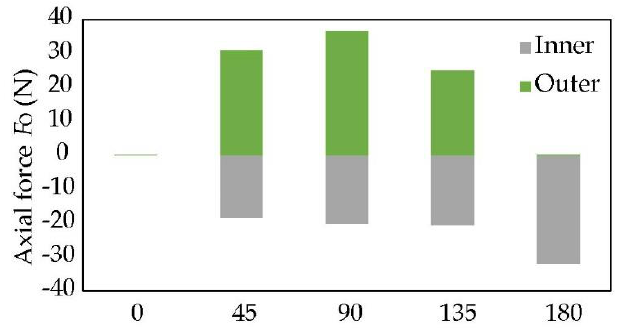
Figure 19. Axial force during short-circuit (upper turns).